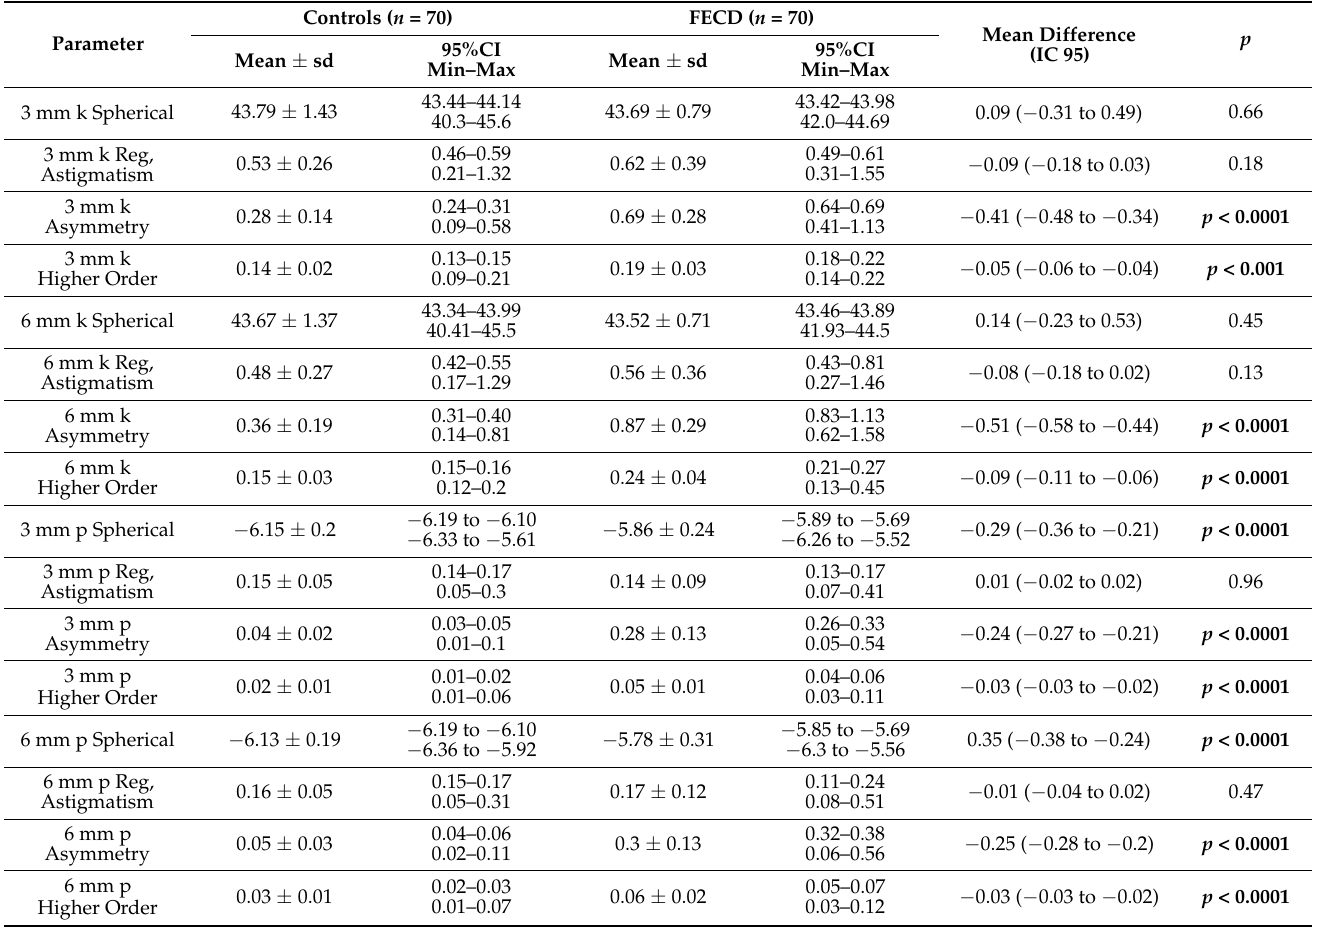
Table 4. Comparison of Fourier indices of the FECD eyes and control